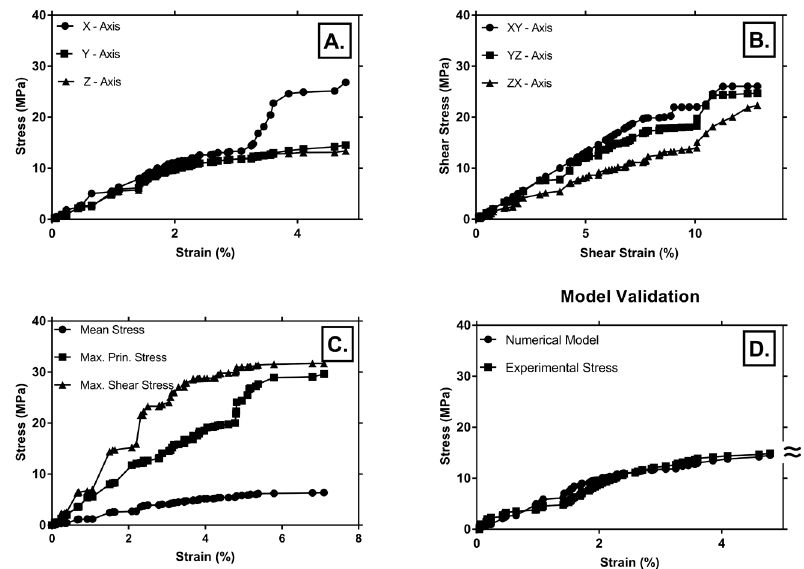
Figure 11. Stress–strain curves for numerical sample: ( A ) stresses in x-, y- and z-axis directions as a function of strain; ( B ) shear stresses in xy, yz and zx directions as a function of strain; ( C ) maximum principal stress, maximum shear stress, and maximum mean stress, as a function of strain; ( D ) comparison of stress–strain curves in the case of experimental and numerical tests.